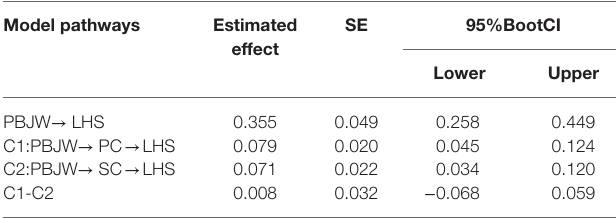
TABLE 2 | Bootstrapping indirect effects and 95% confidence intervals (BootCI) for the mediation